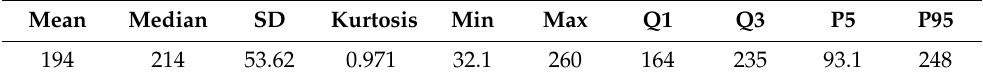
Mean Median SD Kurtosis Min Max Q1 Q3 P5 P95 194 214 53.62 0.971 32.1 260 164 235 93.1